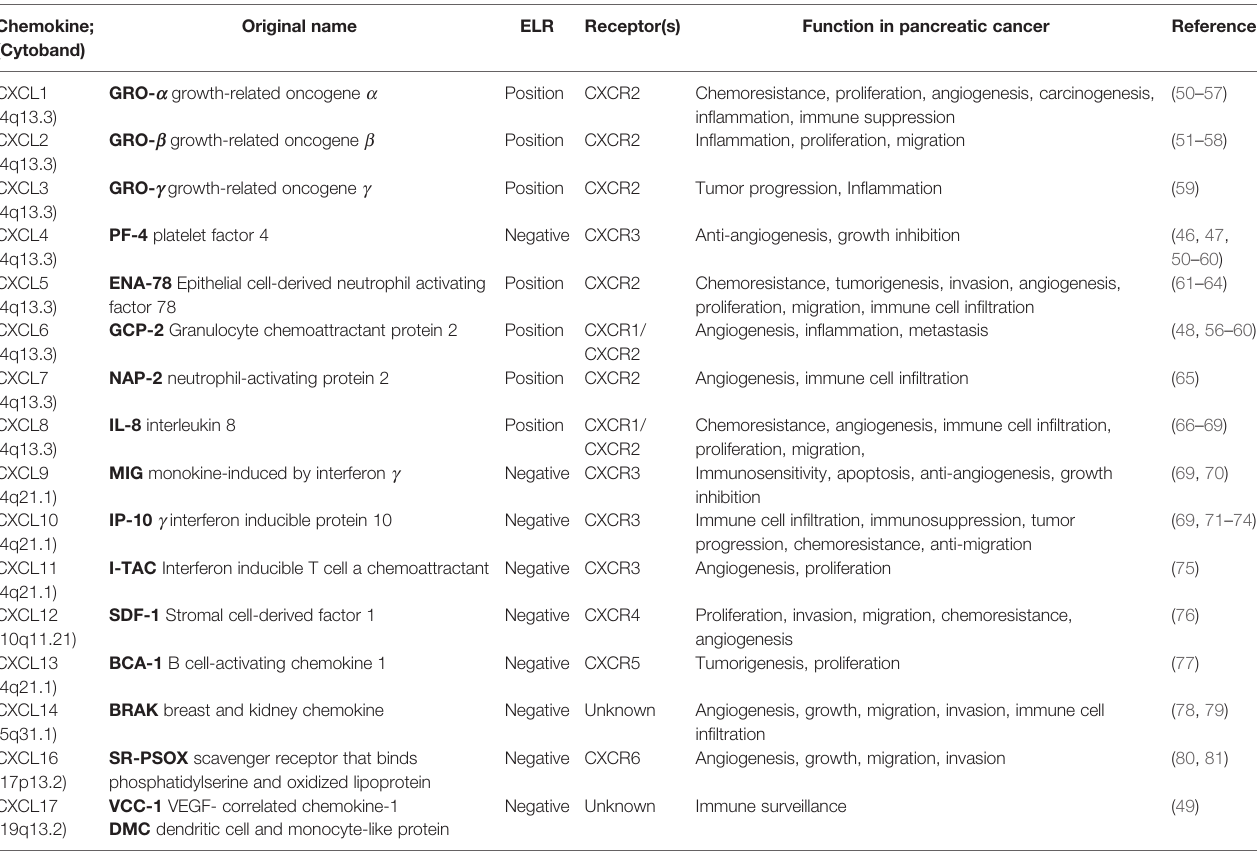
TABLE 8 | CXC chemokines and their functions in pancreatic cancer.